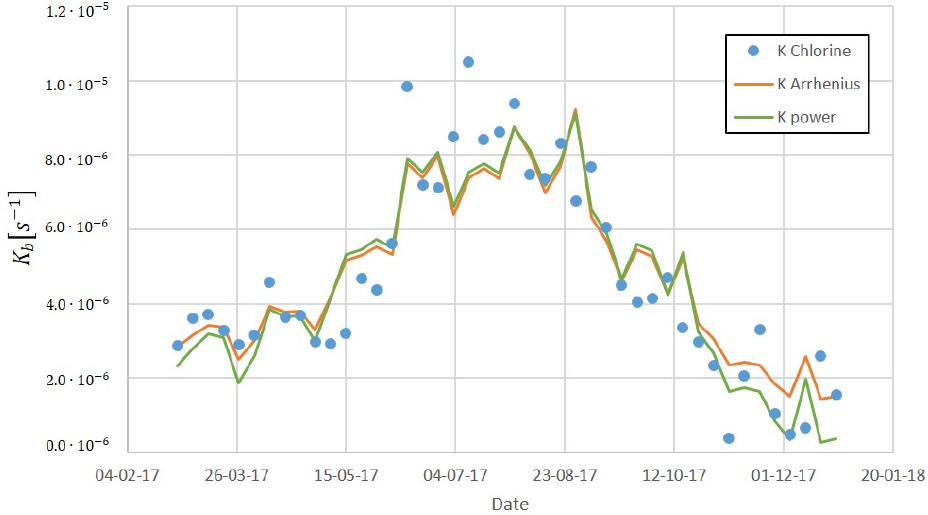
Figure 11. Chlorine decay constant fitting to temperature dependent models using data from 2017.